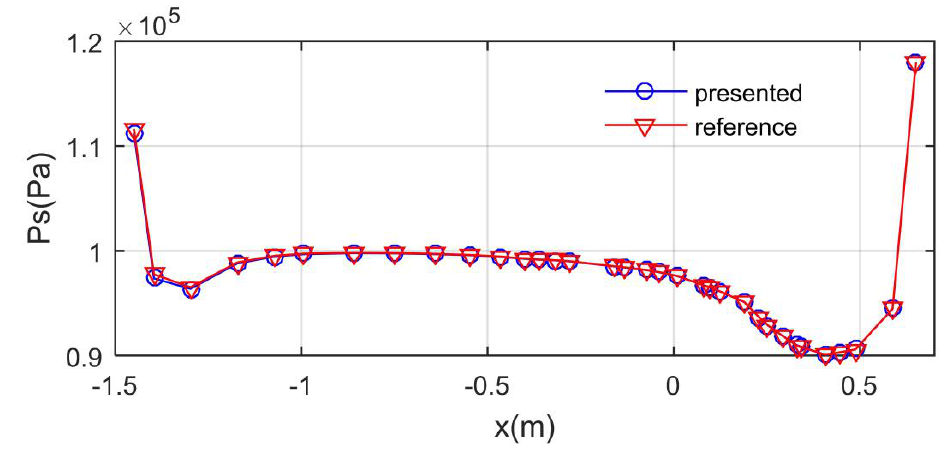
Figure 3. Verification of the CFD method: X t = 0.1 m; vertical tail wall section y > 0 m; z = 1.5 m; V ∞ = 125.8 m/s.